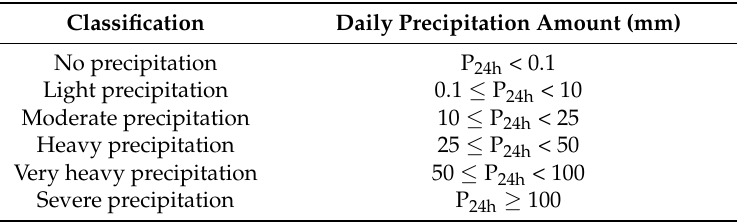
Table 1. Classifications of precipitation intensities and their corresponding daily precipitation amount (P 24h